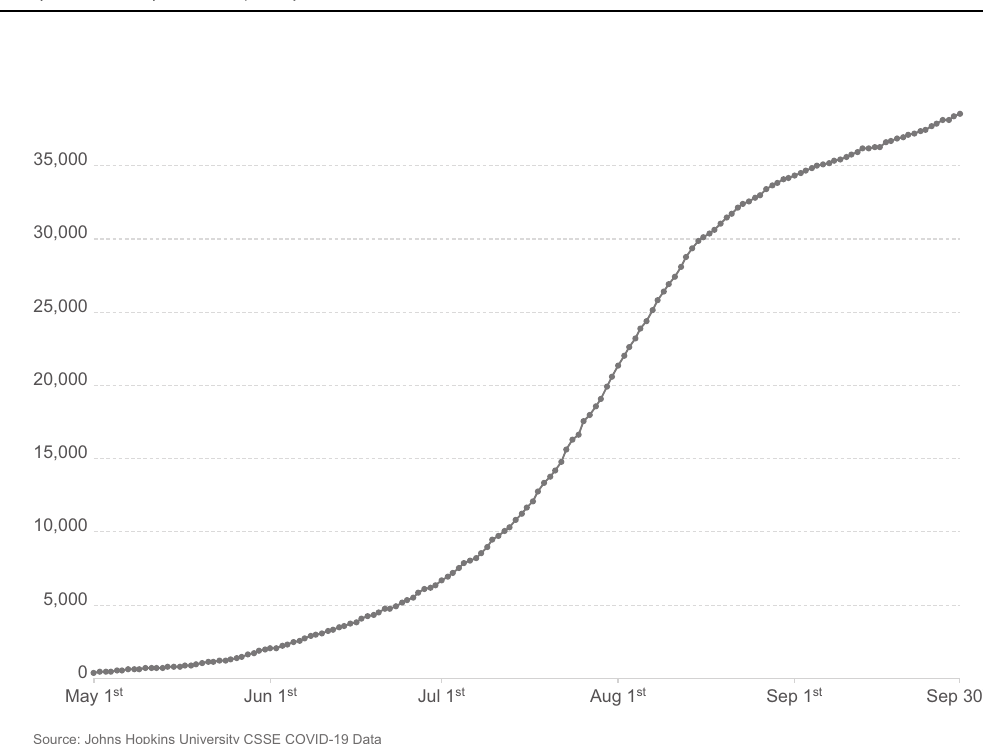
Fig. 1 Cumulative con fi rmed COVID-19 cases in Kenya from 1st May - 20th September